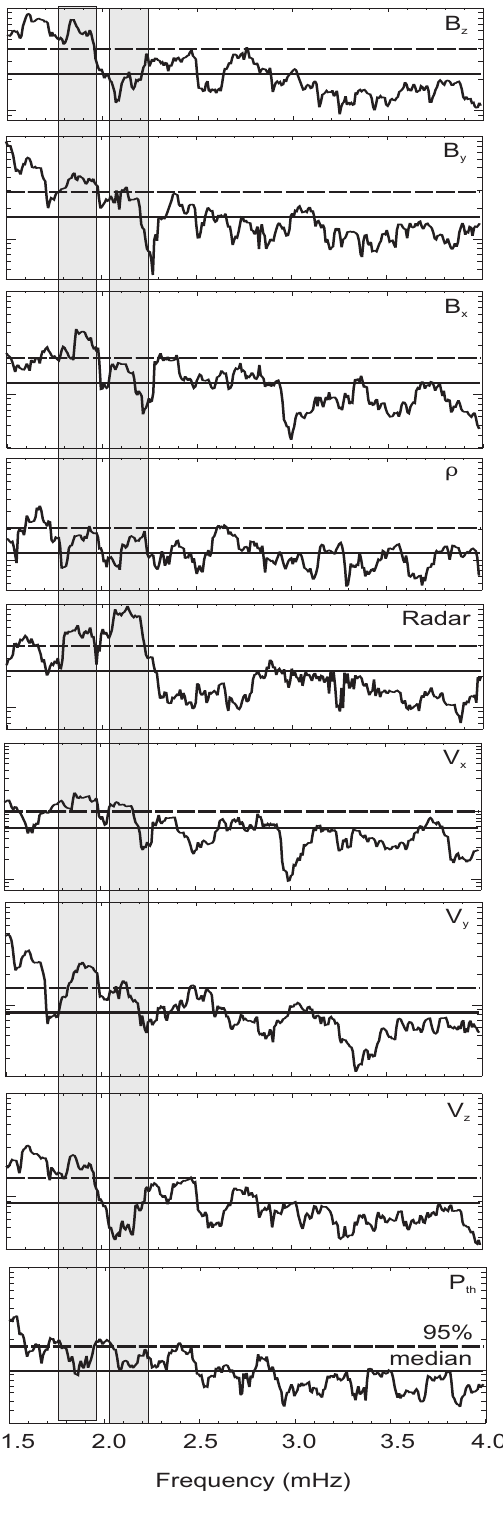
Fig. 5. Multitaper spectra ( NW 4 t = 5 ; K = 8) of ACE components (01:00–20:00UT) and radar Doppler velocity for beam 4 gate 15 (02:31–19:00UT) on 7 June 2000.